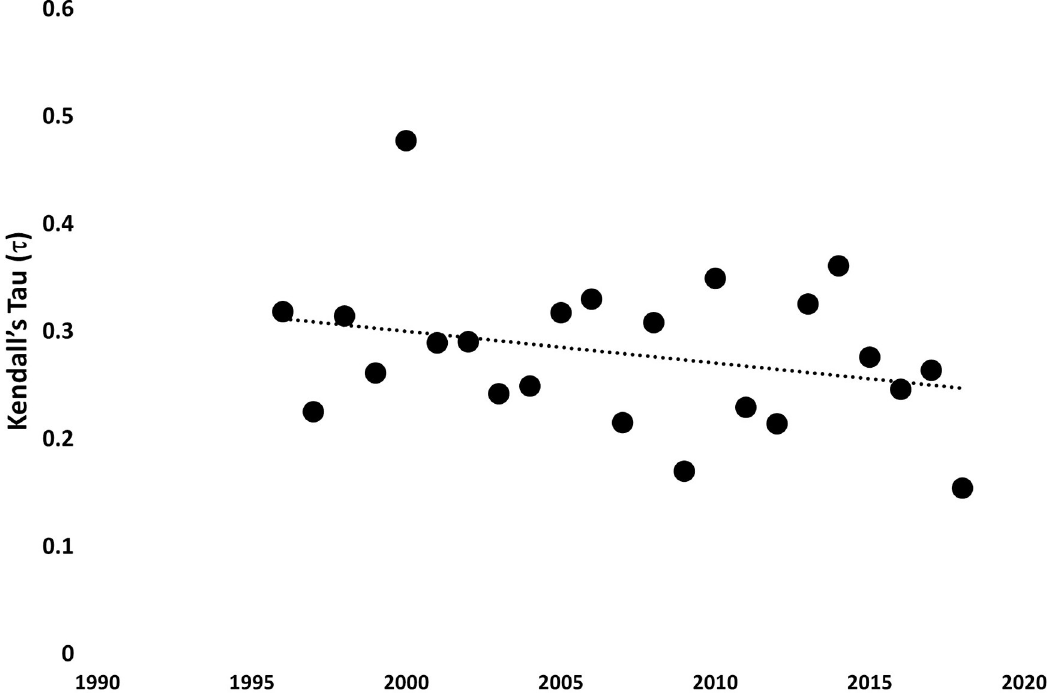
Fig 4. Kendall’s Tau correlation values (p-value < 0.05) between PHYTO FI and PC FI indicate a decline in the connection between phytoplankton and physicochemical dynamics over time.